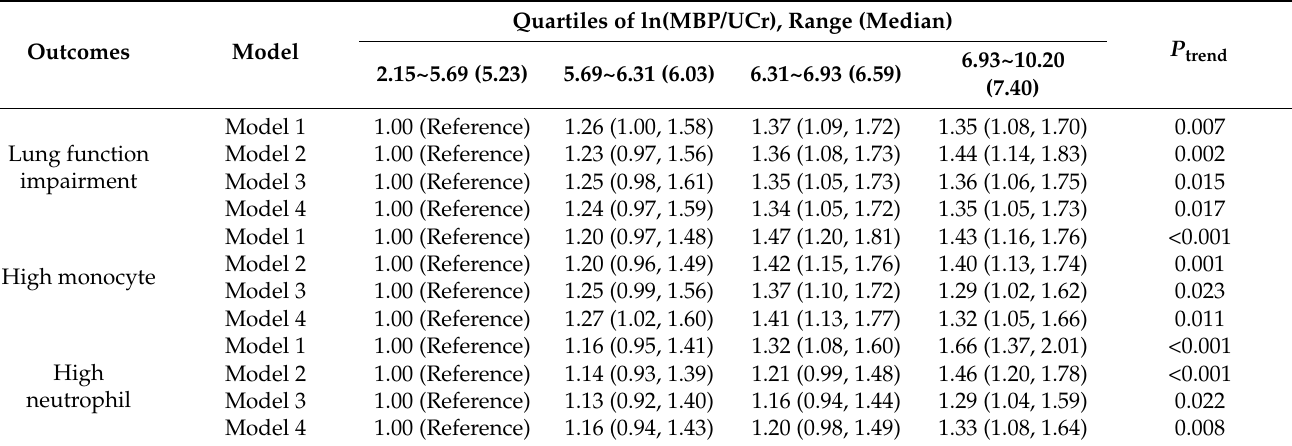
Figure 2. Non-linear dose–response analysis on urinary MBP concentration and lung function impairment. Restricted cubic spline regression with three knots at the 10th, 50th, and 90th percentiles was used to explore the potential dose–response relationship between MBP and lung function impairment. The reference level was set at 6.31. A P non-linearity was obtained by testing the null hypothesis that regression coefficient of the second spline was equal to zero. CI, confidence interval; MBP, mono-benzyl phthalate; OR, odds ratio. Table 3. Association between urinary MBP and the lung function Table 2. The clinical characteristics of study population according to the concentration of urinary MBP.